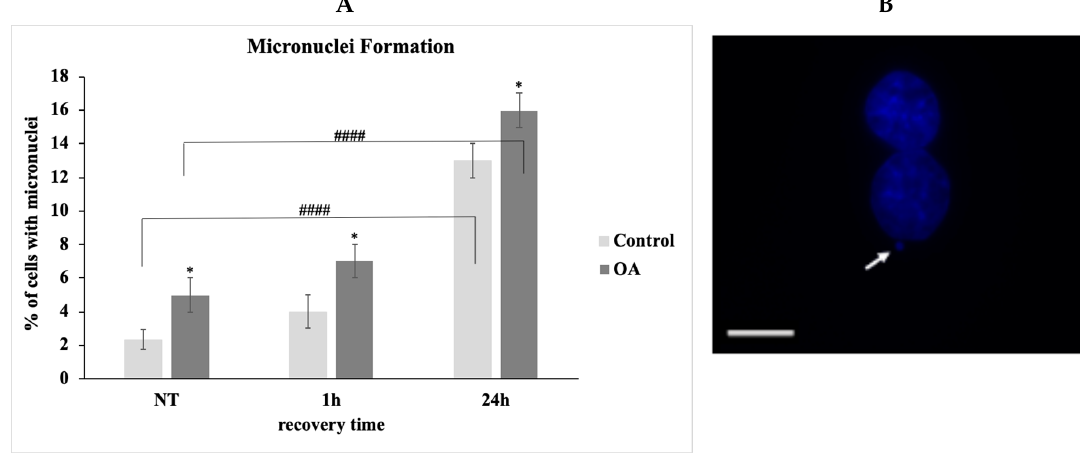
Figure 8. No restoration of OS-induced DNA damage resulted in the formation of a higher number of micronuclei in OA chondrocytes. ( A ) Percentages of chondrocytes from three control and three OA patientssamplesevaluatedforthepresenceofmicronucleiundernormalconditions(NoTreatment—NT) and at di ff erent time points of recovery period from the oxidative treatment (1 h and 24 h). Values shown are the means ± S.E. * p < 0.05 vs. control cells and #### p < 0.001 vs. NT. p values were calculated using the Student t -test. ( B ) Characteristic images of a micronucleus (arrow) in OA chondrocytes. Nuclei were stained with DAPI (blue). Images were captured with the 40 × objective lens of the fluorescence microscope. Scale bar 25 µ m.